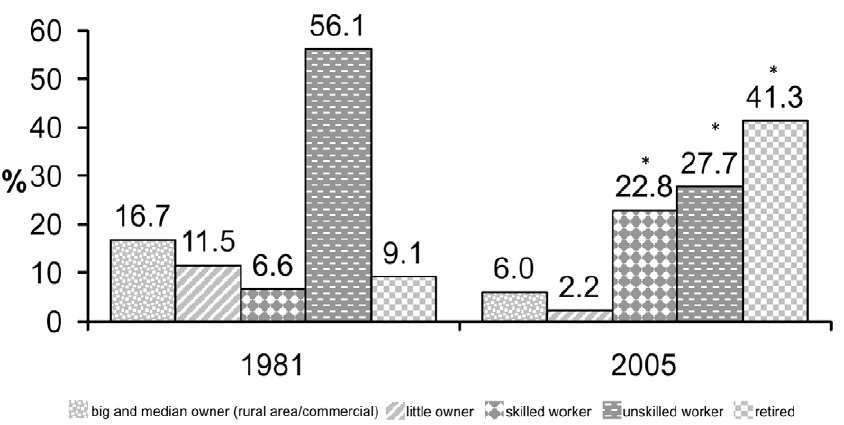
Figure 1. Data on the activities of the family heads in Comercinho/MG, Brazil (1981–2005). The figure 1 shows the proportion related to the heads of the households considered as skilled workers, which increased throughout the mentioned years. * p-value , 0.001.